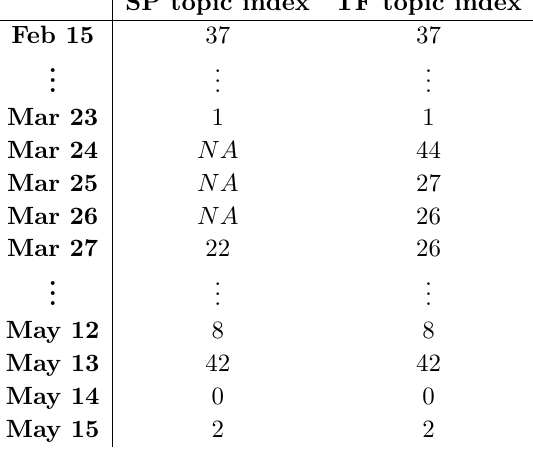
Table F.2. A portion of connected presidential election topics via the shortest path mechanism (left column) and the TopicFlow mechanism (right column) using the same distance metric (Hellinger). Here topics are indicated by their indices, e.g., 0 − 49 , at each timestamp timestamps (row index). NA indicates that no